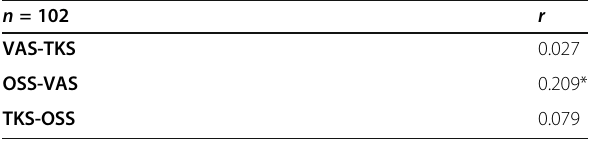
Table 5 Correlation between VAS, OSS and TKS n = 102 r VAS-TKS 0.027 OSS-VAS 0.209* TKS-OSS